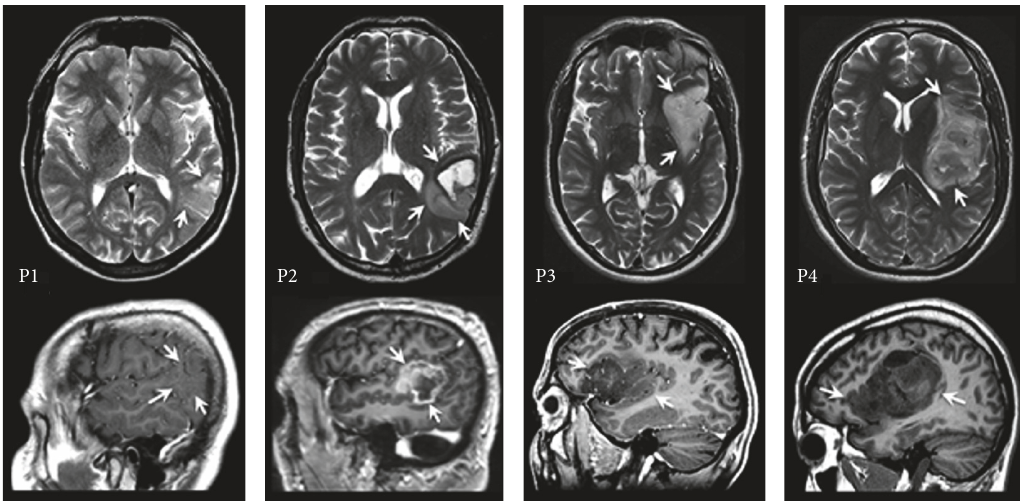
Figure 1: Preoperative MRI scans axial T2 weighted and sagittal T1 weighted (contrast-enhanced in P1 and in P3) sections depicting tumor localization (arrows).